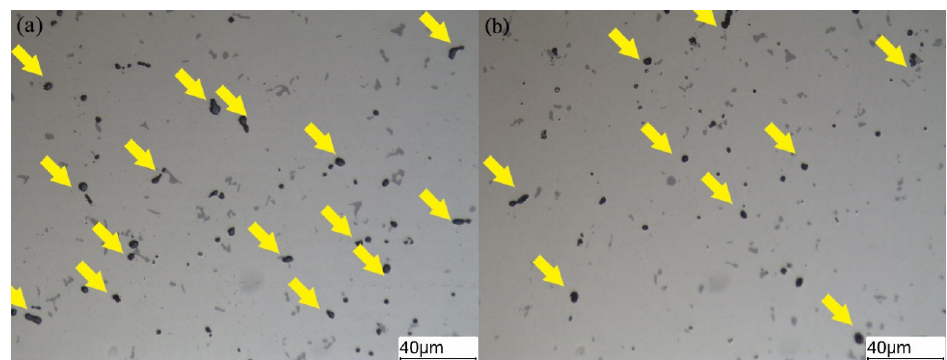
Figure 2. Optical micrographs show second ‐ phase particles located in the matrix of ( a ) T6; ( b ) CFT6a sample; non ‐ etched cross ‐ section in transverse direction. Table 2. The SP and/or IMC particles measured from T6 and CFT6a samples; maximum particle size and count population were included.